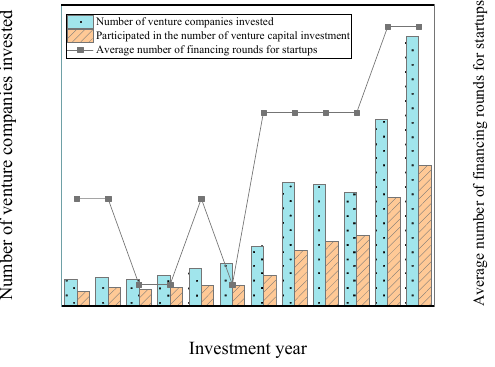
Figure 1. Venture capital transactions from 2009 to